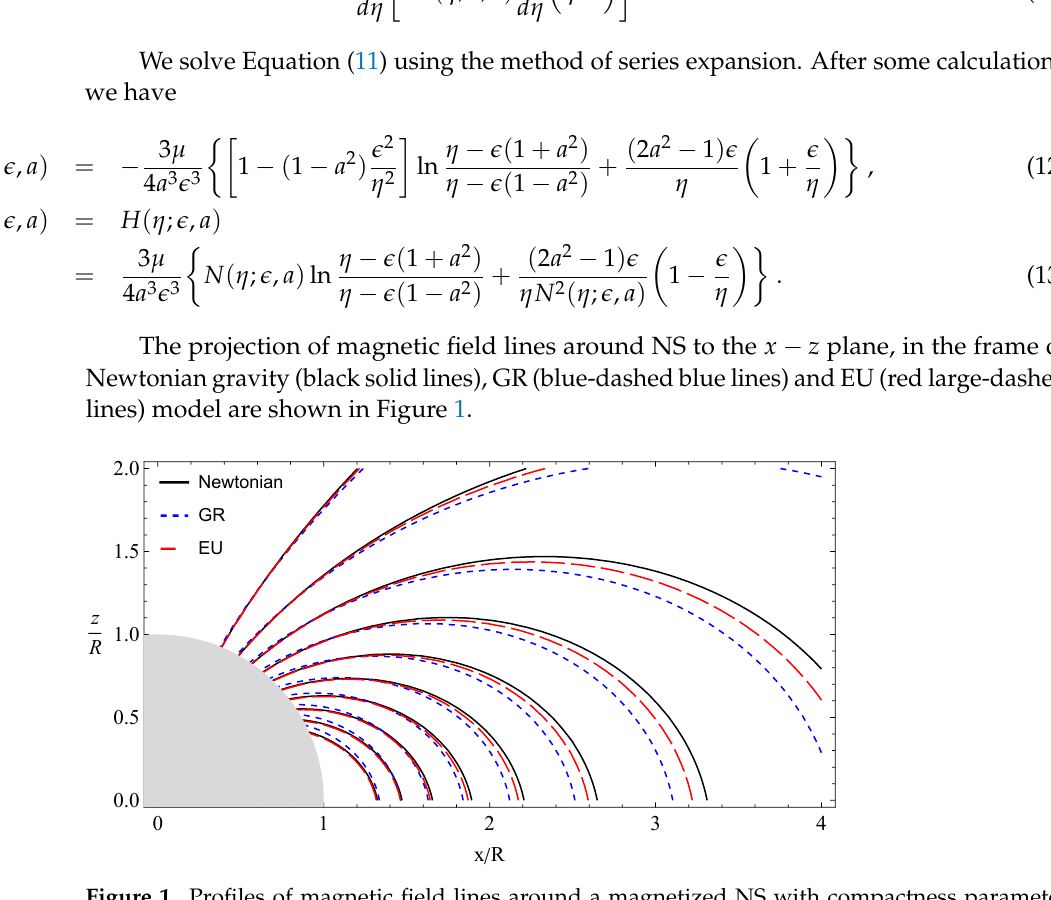
Figure 1. Profiles of magnetic field lines around a magnetized NS with compactness parameter (cid:101) = 0.2 and inclination angle χ = π /6 corresponding to Newtonian gravity (black line), GR (blue dashed line) and EU (red large-dashed line)